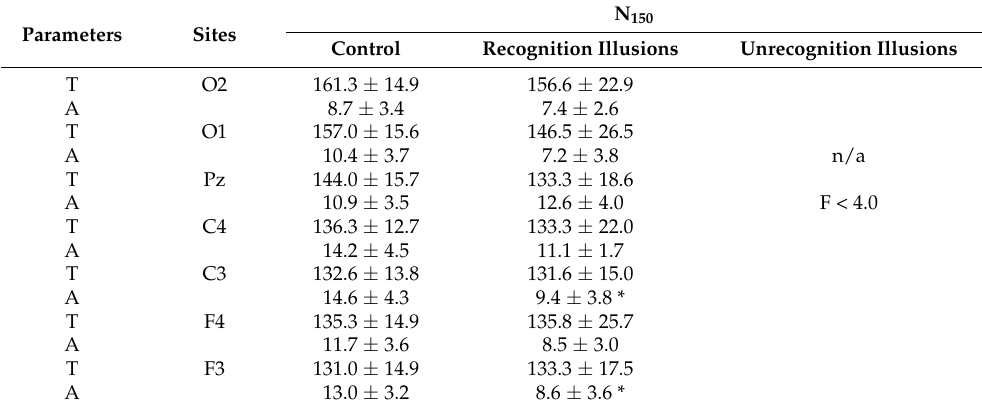
Table 2. Amplitude (A, uV) and time (T, ms) characteristics of the component N 150 ERP. N 150 Parameters Sites Control Recognition Illusions